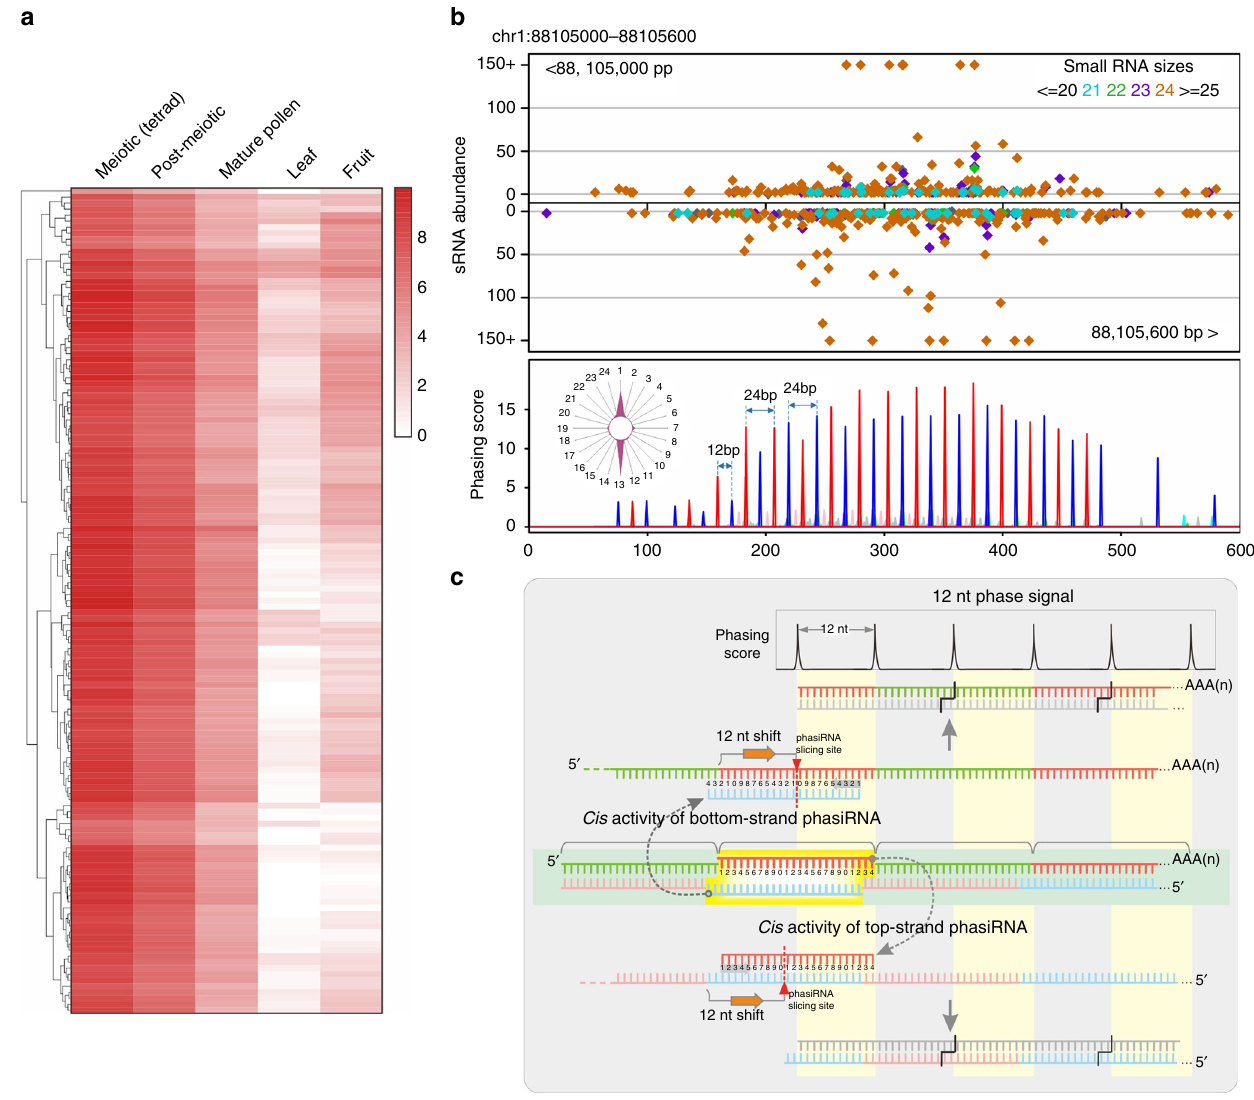
Fig. 4 24-nt phasiRNAs with 12-nt phasing in tomato. a 24-nt phasiRNA accumulation in different tissues of tomato, with each row denoting a 24 -PHAS locus. b A representative locus generating 24-nt phasiRNAs in tomato. Distribution of sRNAs (above) and deduced phasing score (below) are viewed along the coordinates of the PHAS locus, with phasiRNA distribution in registers displayed in a radar plot on the left. c A hypothesis for the generation of 24-nt phasiRNAs with a 12-nt phasing pattern. Cis activity of either strand of a 24-nt phasiRNA duplex could trigger secondary phasing with a 12-nt shift to the primary 24-nt phase. The combination of the primary and secondary phases leads to the formation of the 12-nt phase